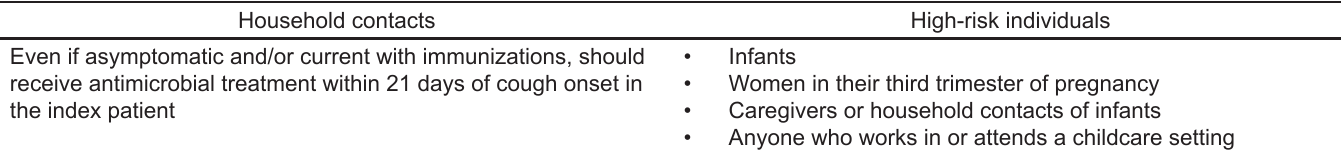
Table. Candidates for pertussis post-exposure